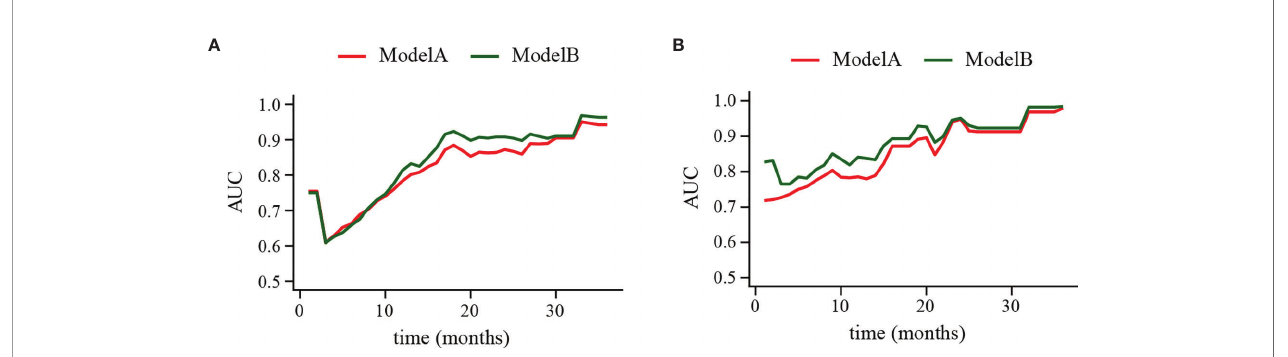
FIGURE 4 | Time-dependent receiver operating characteristic (ROC) curve of ModelA and ModelB in the training (A) and validation cohort (B) . The y-axis represents the area under curve (AUC) and the x-axis represents the follow-up time. In the most points of follow-up time, the AUC value of ModelB (green line) was higher than ModelA (red line).